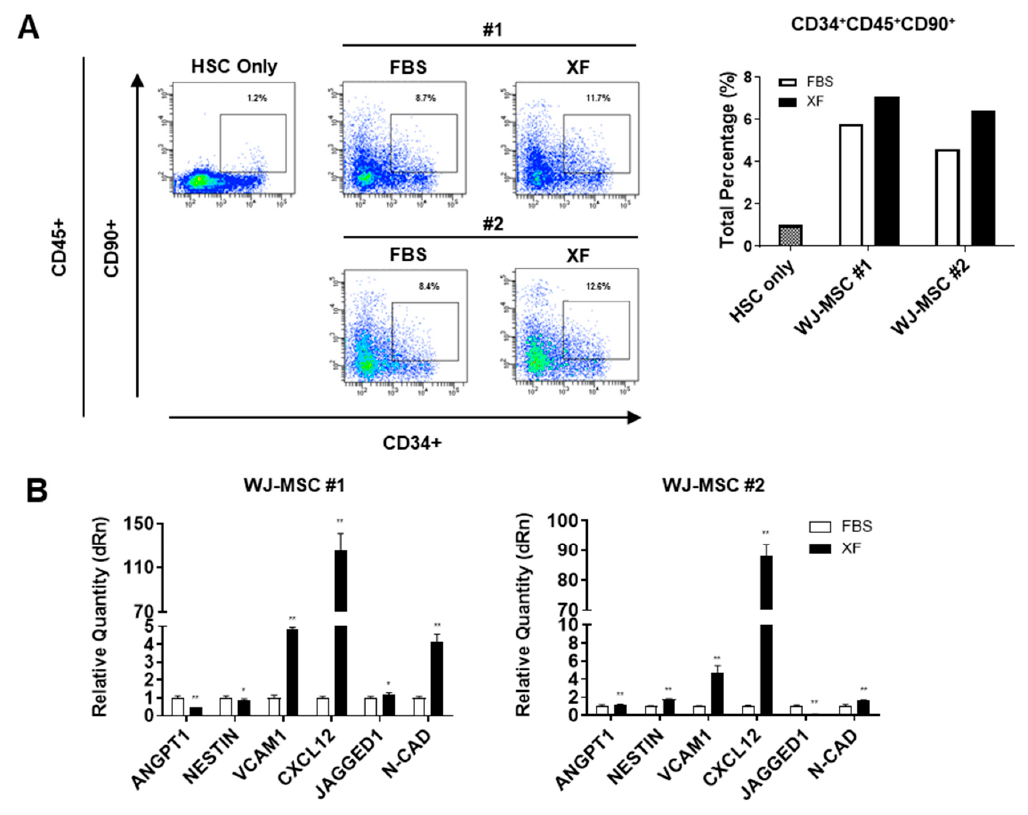
Figure 3. XF-MSCs support the human CD34 + CD90 + HSC activity. ( A ) UCB-derived CD34 + HSC were co-cultured with 10%-MSCs or XF-MSCs for 6 days, and the percentage of CD45 + , CD34 + , CD90 + HSC subpopulations were measured using flow cytometry. The flow cytometry plots are representative of independent experiments performed at least three times. ( B ) mRNA expressions of HSC niche related genes in 10%-MSCs or XF-MSCs were determined by qRT-PCR and normalized to GAPDH (* p < 0.05, ** p <